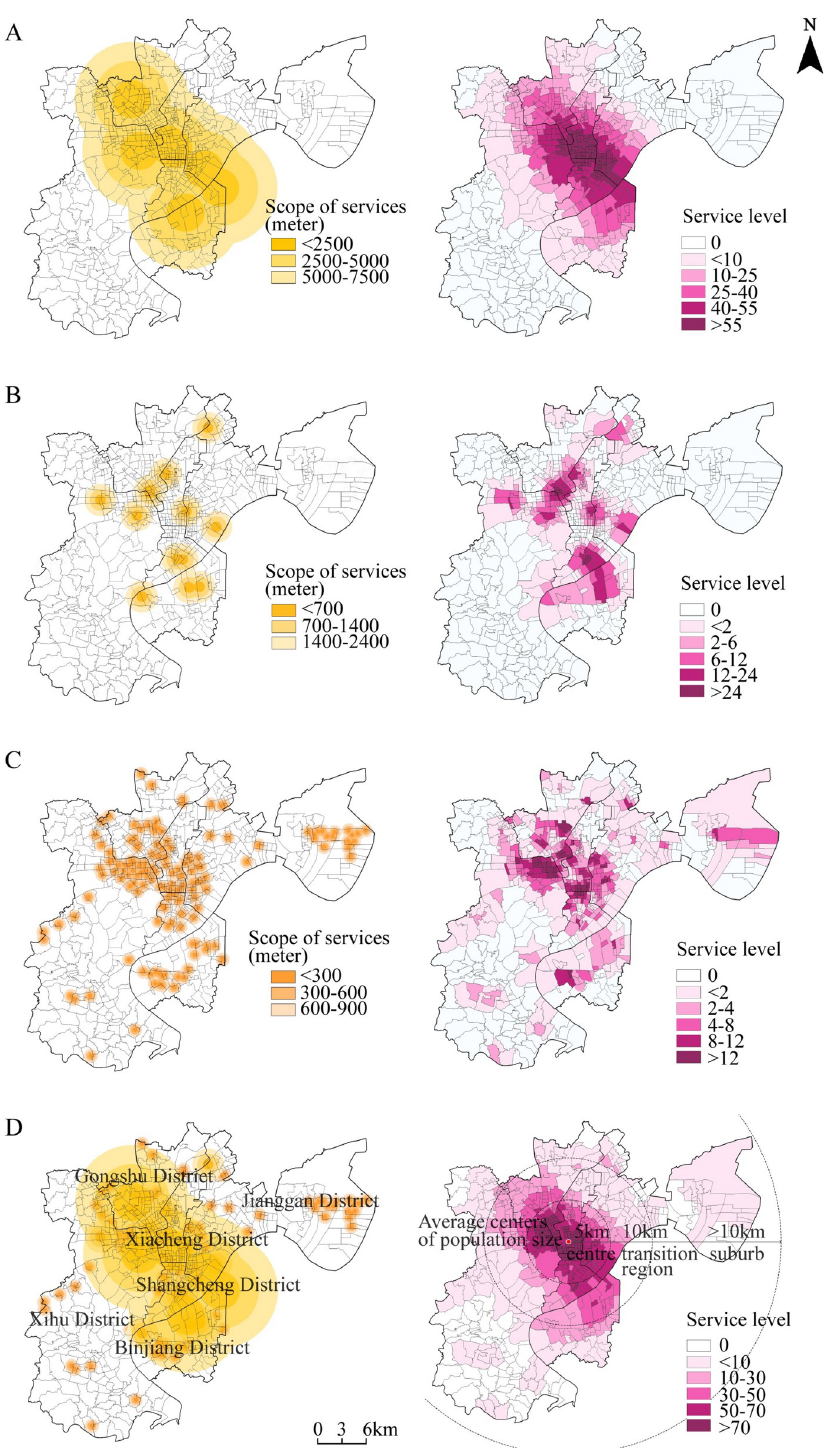
Fig 3. Spatial distribution of effective service coverage range and service level of sports facilities in Hangzhou: (A) Spatial distribution of effective service scope and service level of public sports facilities at province(city)-level; (B) Spatial distribution of effective service scope and service level of public sports facilities at District-level; (C) Spatial distribution of effective service scope and service level of public sports facilities at Subdistrict-level; (D) Spatial distribution and rings distribution of overall effective service scope and service level of public sports facilities. Source: